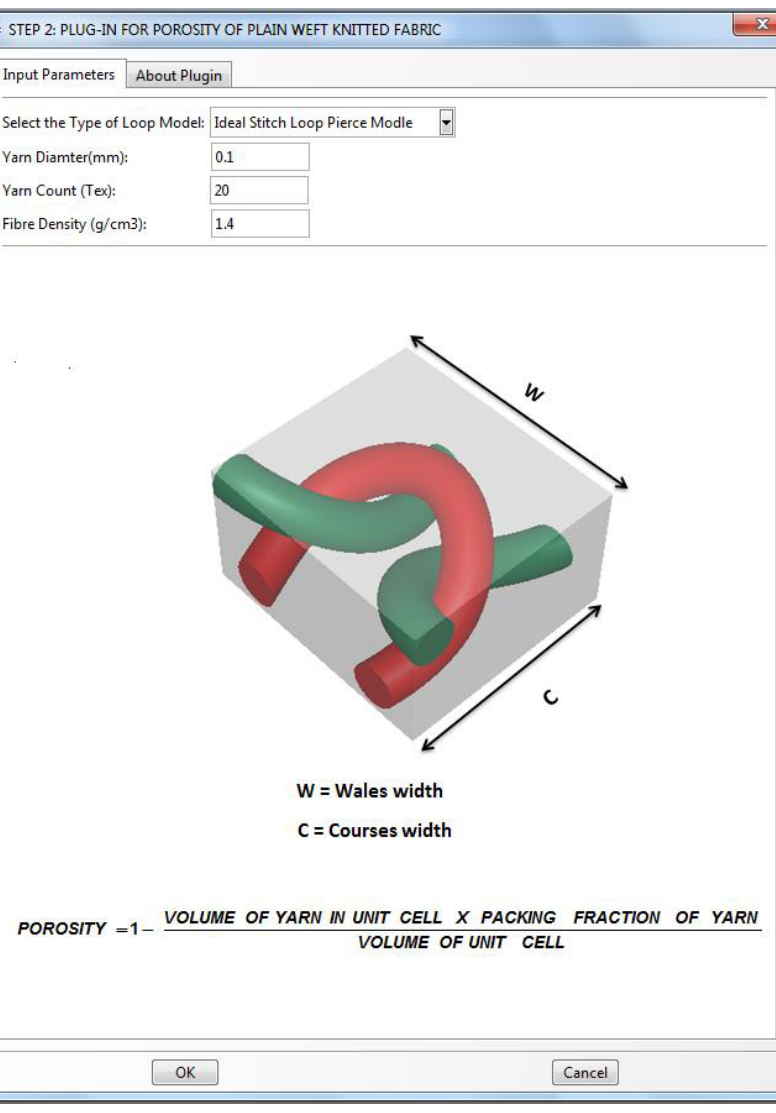
Figure 6. Plug-in for porosity of plain weft knitted